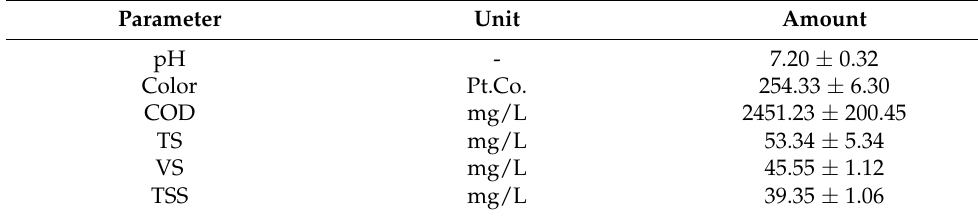
Table 3. Physio-chemical properties of the influent. Parameter Unit Amount pH - 7.20 ± 0.32 Color Pt.Co. 254.33 ± 6.30 COD